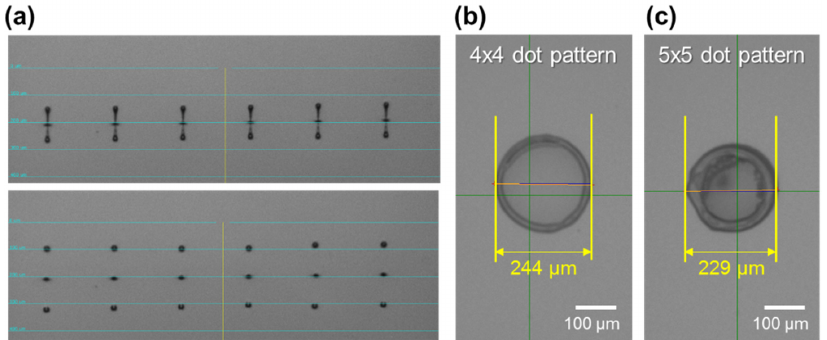
Figure 1. ( a ) Optical images of inkjet-printed indium-gallium-zinc-oxide (IGZO) droplets from inkjet head, and optical images of IGZO channel layers printed by ( b ) 4 × 4, and ( c ) 5 × 5 dot array patterns.